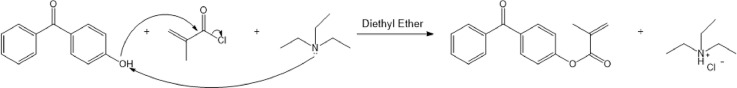
Mechanism for the synthesis of monomer 3: 4-benzoylphenyl methacrylate (BPM).Reagents: 4-hydroxybenzophenone (98%), diethyl ether, triethyl amine (99.5%), methacryloyl chloride (97%), DI water, sodium hydroxide pellets and magnesium sulfate.